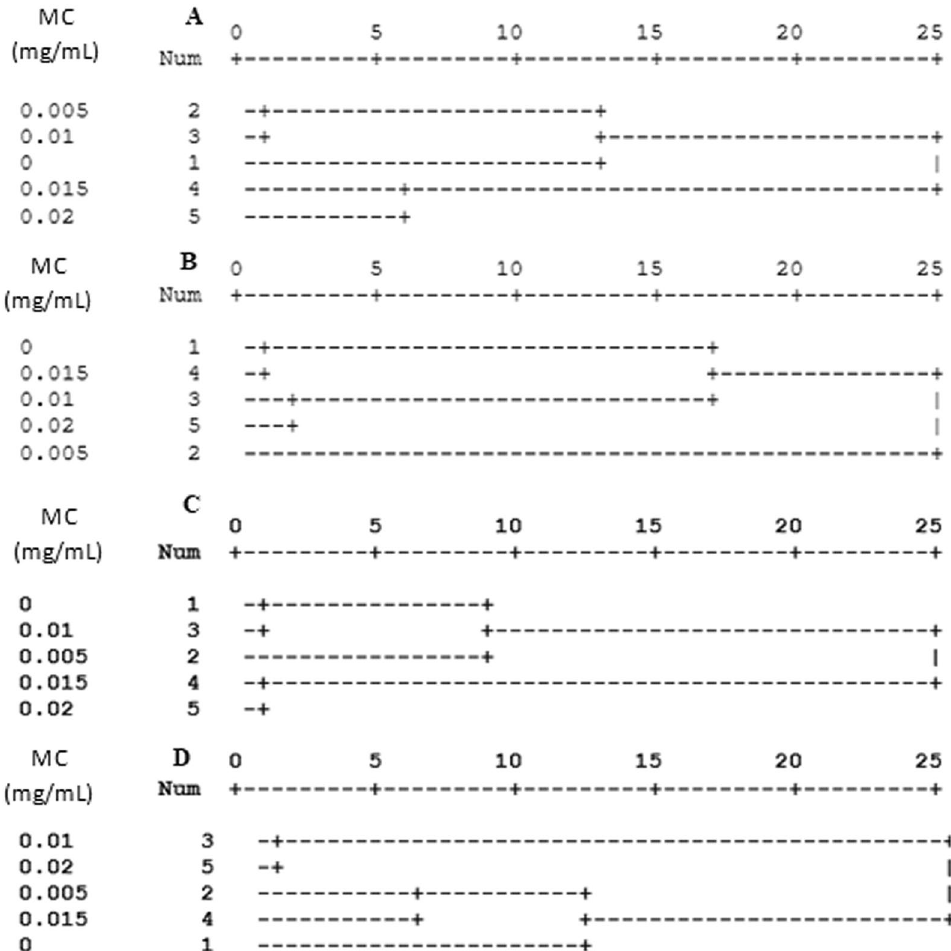
Figure 4. Dendrogram of the cluster analysis (using Ward ′ s Method) applied for oxidative stress assessment (in form of cluster the reactive oxygen species concentration (ROS), and macromolecules damage) in the gut homogenate of 5th larval instar ( A ), and male adult stage ( B ) of Hermetia illucens. The cluster analysis which applied for antioxidant response system (inform of enzymatic antioxidant response and non-enzymatic antioxidant response) in the gut homogenate of 5th larval instar ( C ), and male adult stage ( D ) of Hermetia illucens , which their food containers were exposure to different concentration of malathion (0, 0.005, 0.01, 0.015, 0.02